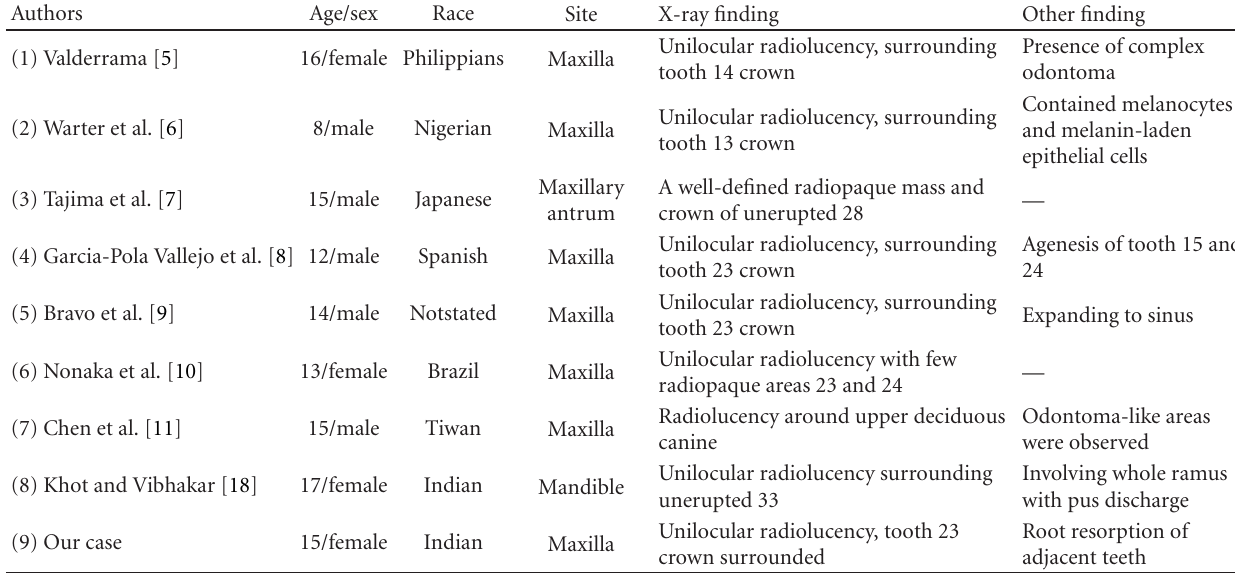
Table 1: A systematic Clinical data of the reported cases of adenomatoid odontogenic tumor arising from a dentigerous cyst in pediatric age group till